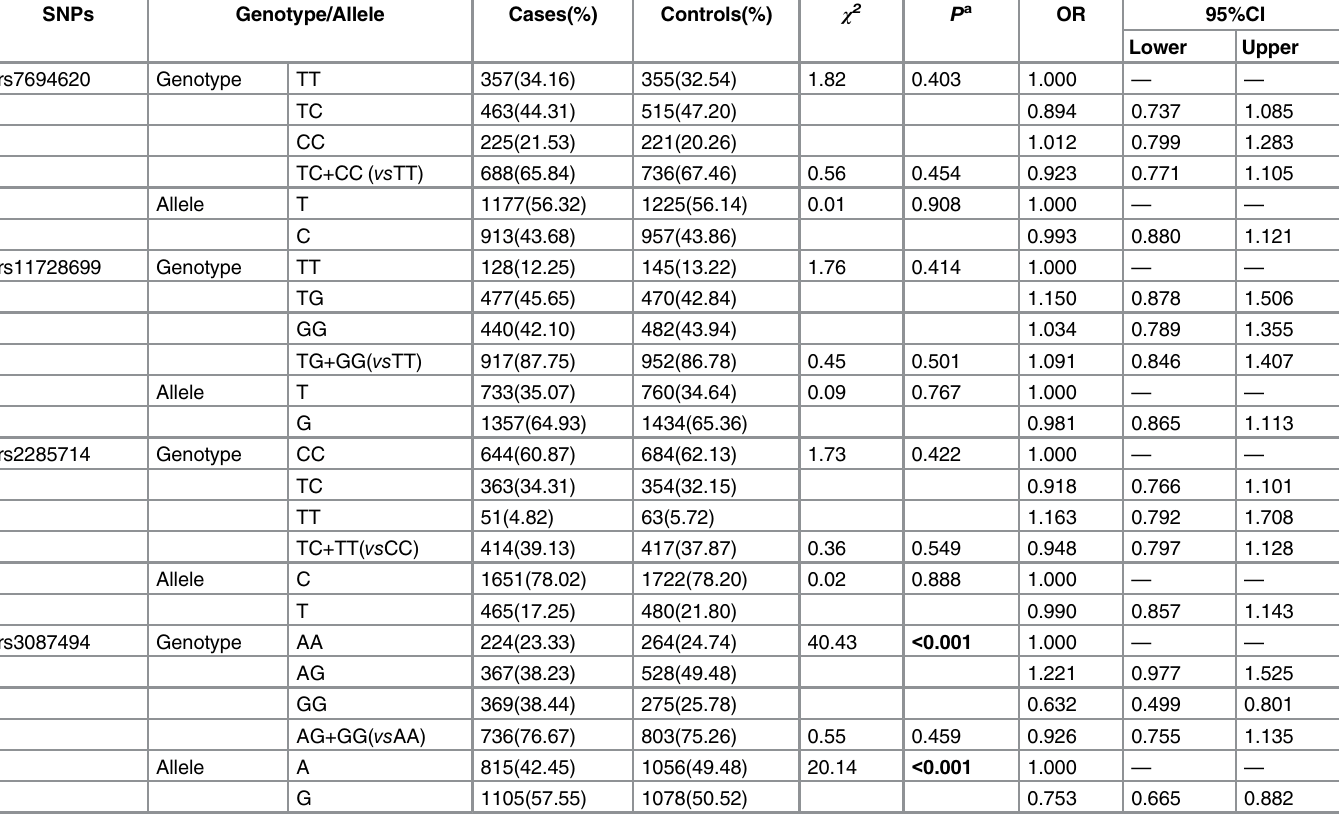
Table 2. Genotype distribution and allele frequency differences between schizophrenia patients and healthy controls for four PLA2G12A